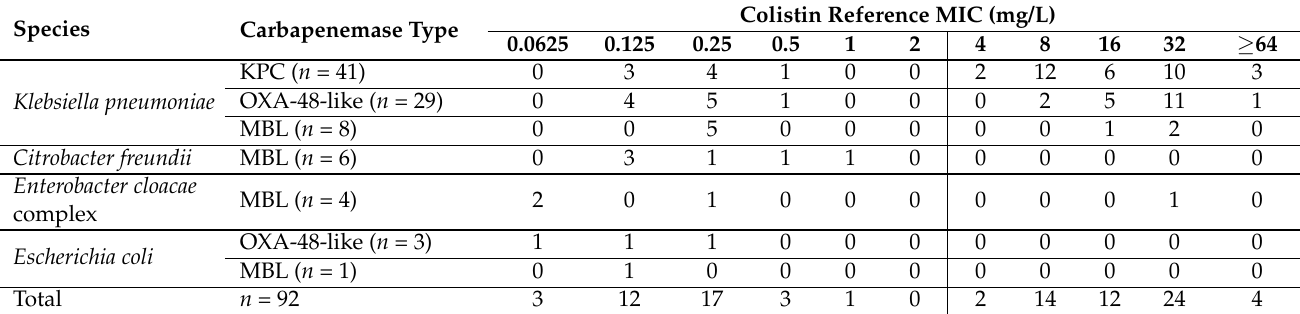
Table 1. Distributions of colistin MICs determined by BMD for all isolates. Colistin Reference MIC (mg/L) Species Carbapenemase